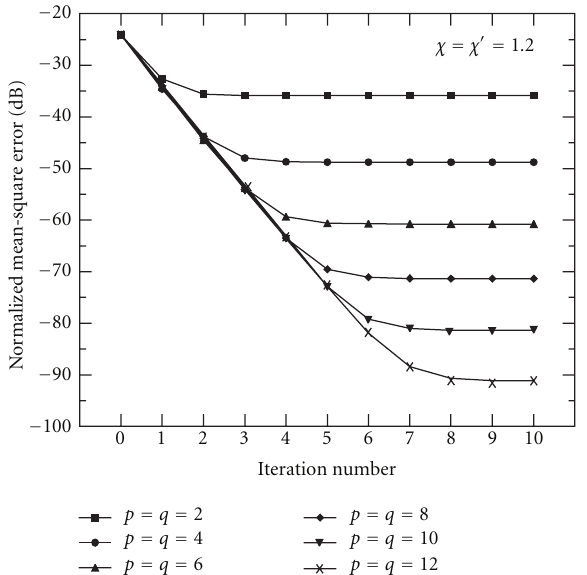
Figure 5: Normalized mean-square error in the reconstruction of the uniform helicoidal samples.